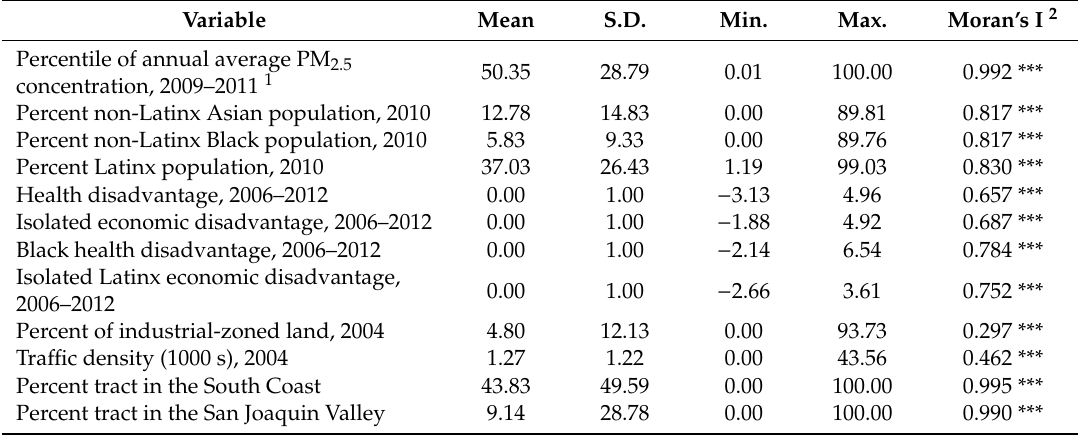
Table 3. Descriptive statistics of variables used in the bivariate correlation and spatial lag regression analyses ( N = 7533